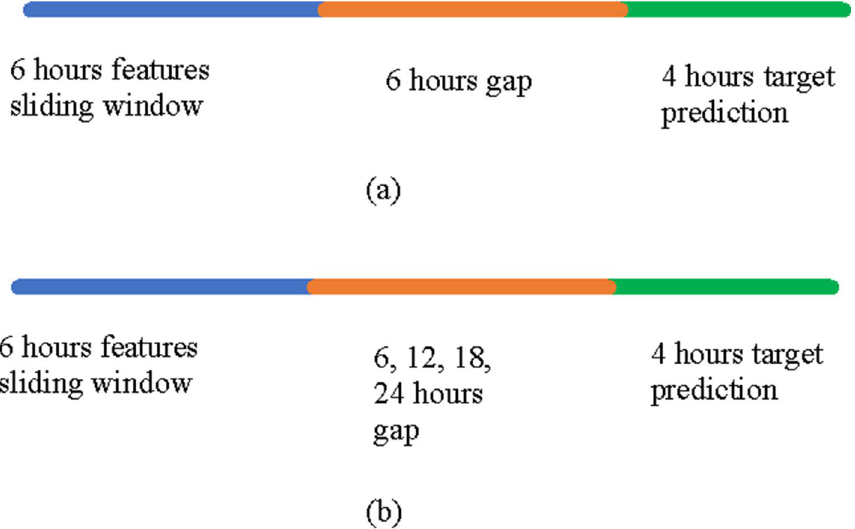
Figure 1. The sliding window prediction schemes. ( a ) In the first prediction window, the point of reference is at the end of the 6-h features sliding window. The model predicted the onset of invasive mechanical ventilation at the 4-h target prediction period while ignoring the six hours gap period. ( b ) A widened sliding window prediction scheme. This is a scheme similar to ( a ) but the gap period here varies between 6 to 24 h for the prediction of invasive mechanical